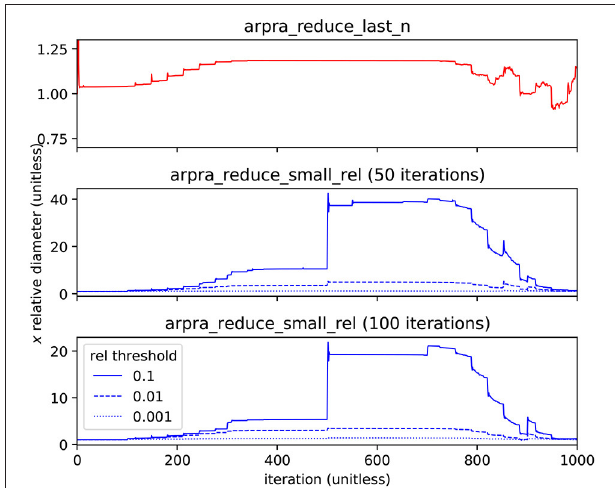
FIGURE 4 | Diameter of the Hénon map’s x range with term reduction, relative to that of x computed without. The top plot shows x condensed with arpra_reduce_last_n (red) each iteration, resulting in a reduced deviation term count (see Table 1 ) at the expense of minor overhead error. The middle and bottom plots show x condensed with arpra_reduce_small_rel (blue) every 50 and 100 iterations, respectively, each with relative thresholds 0.001 (dotted), 0.01 (dashed) and 0.1 (solid). Deviation term count is reduced considerably, but range diameters are comparatively larger. Note how the condensing of small deviation terms typically leads to an uptick of the relative diameter every 50 (every 100) steps. The relative threshold of 0.1 is clearly too aggressive, as can be seen by the large jump in relative diameter at step 500.